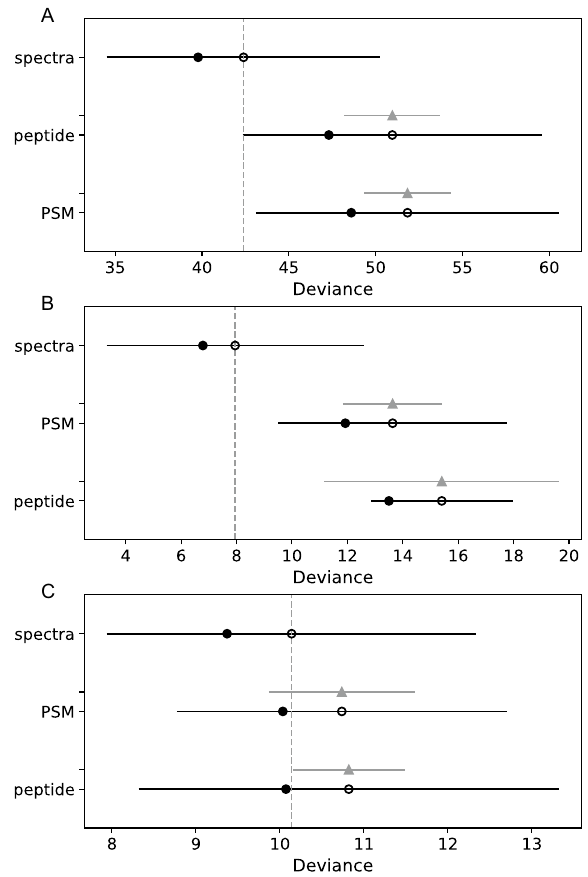
Figure 5. Comparison of peptide, PSM, and spectra models using PSIS-LOO. PSIS-LOO estimates comparing pointwise out-of-sample prediction accuracy demonstrate that the spectra method outperforms the PSM and peptide methods for species ( A ), order ( B ) and human identification ( C ). Solid circles are the in-sample deviance of each model, open circles are the PSIS-LOO estimate, and the solid dark line that passes through the open circle is the standard error of the estimate. The grey triangle and grey lines show the standard error of the difference between each PSIS-LOO and the top-ranked